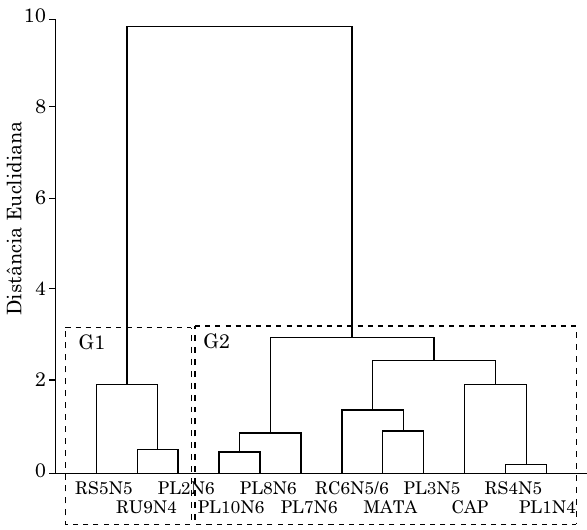
Figura 1. Dendrograma resultante da análise de agrupamento das diferentes áreas, utilizando a distância euclidiana como coeficiente de similaridade e o algoritmo Ward como método de agrupamento quanto aos atributos bioquímicos e